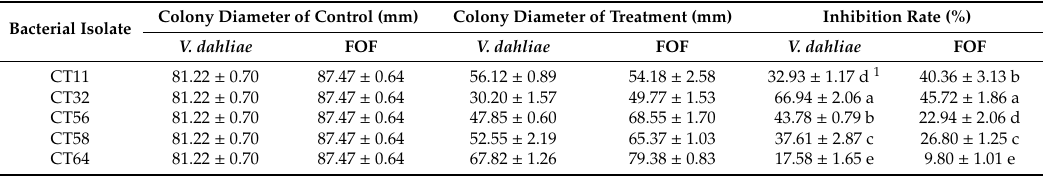
Table 1. Inhibitory e ff ect of volatile compounds produced by antagonistic bacteria on the mycelial growth of V. dahliae and F. oxysporum f. sp. fragariae (FOF). Bacterial Isolate